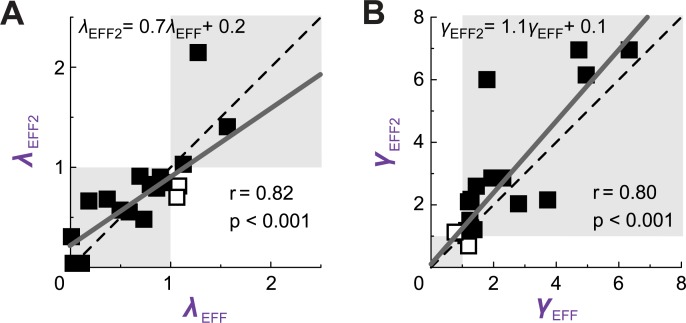
Consistency of parameters.For each subject, comparison of EFF and EFF2 parameter fits for (A) loss aversion and (B) value sensitivity. Closed squares (points in the shaded region) indicate similar directionality in parameter estimates between the two tasks, whereas open squares indicate opposing directionality. Linear regression lines are also shown for these significant correlations.